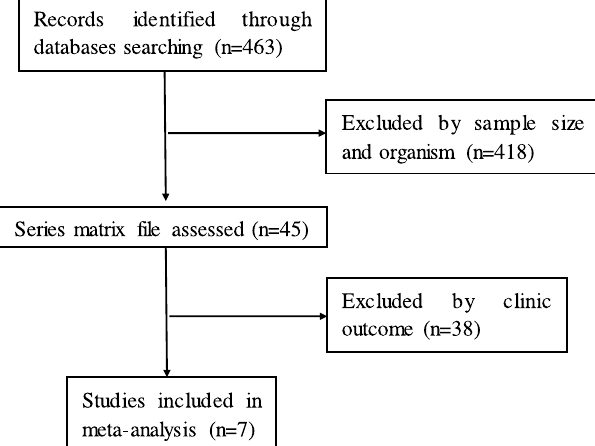
Figure 1. Flow diagram of dataset selection process.